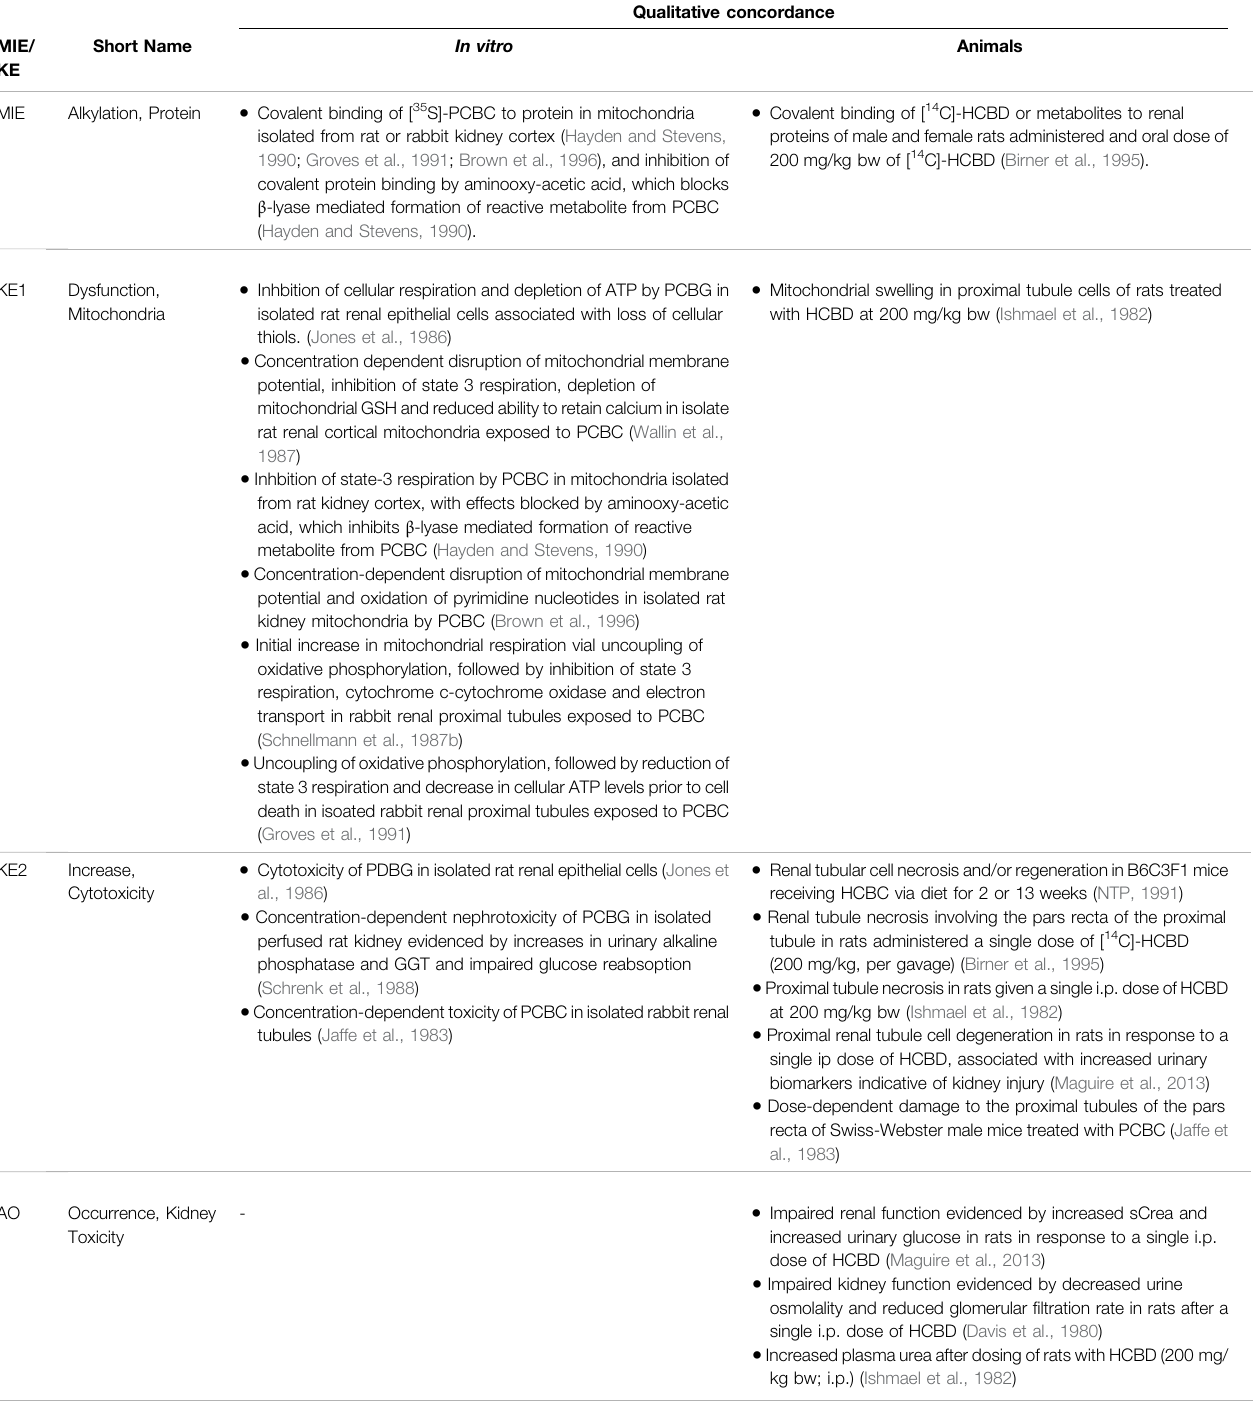
TABLE 7C | Evidence from human, animal and in vitro studies on hexachloro-1,3-butadiene (HCBD) and its glutathione- and cysteine- S -conjugates (S- (pentachlorbutadienyl)glutathione(PCBG)and S